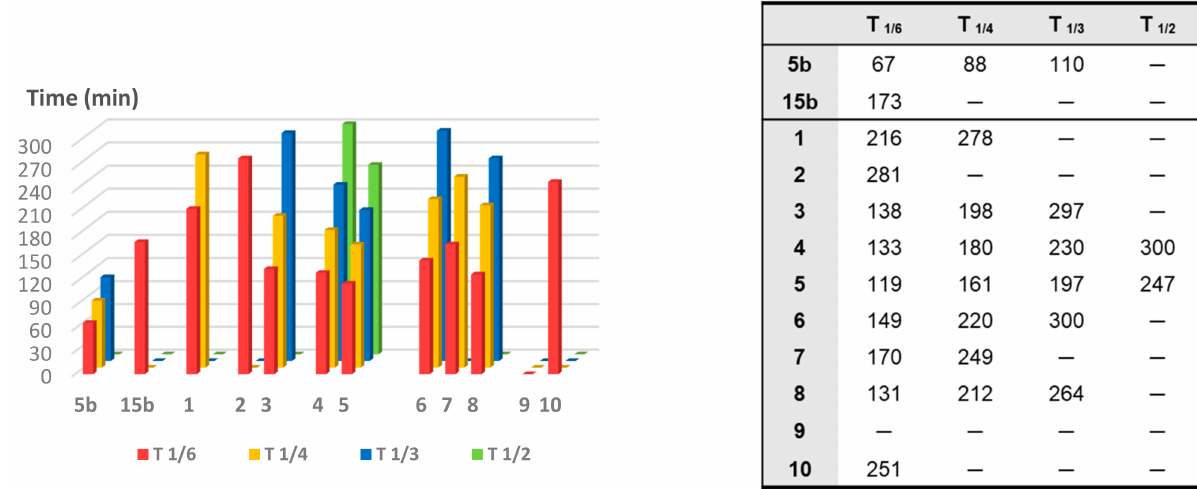
Figure 5. T 1/6 , T 1/4 , T 1/3 and T 1/2 values (defined as the time necessary for a CO-RM solution to produce a Mb-CO concentration equal, respectively, to 1/6, 1/4, 1/3, and 1/2 of its initial concentration) of the analyzed compounds based on the spectrophotometric assay. The bar graph (left) represents values reported in the table